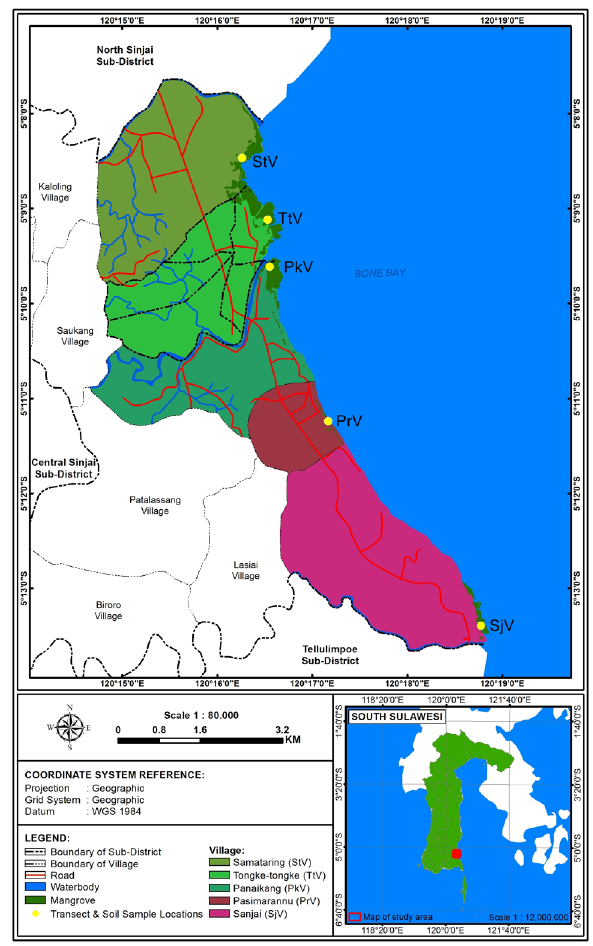
Figure 1. Study area: Sinjai District, South Sulawesi, Indonesia The distance to the capital of South